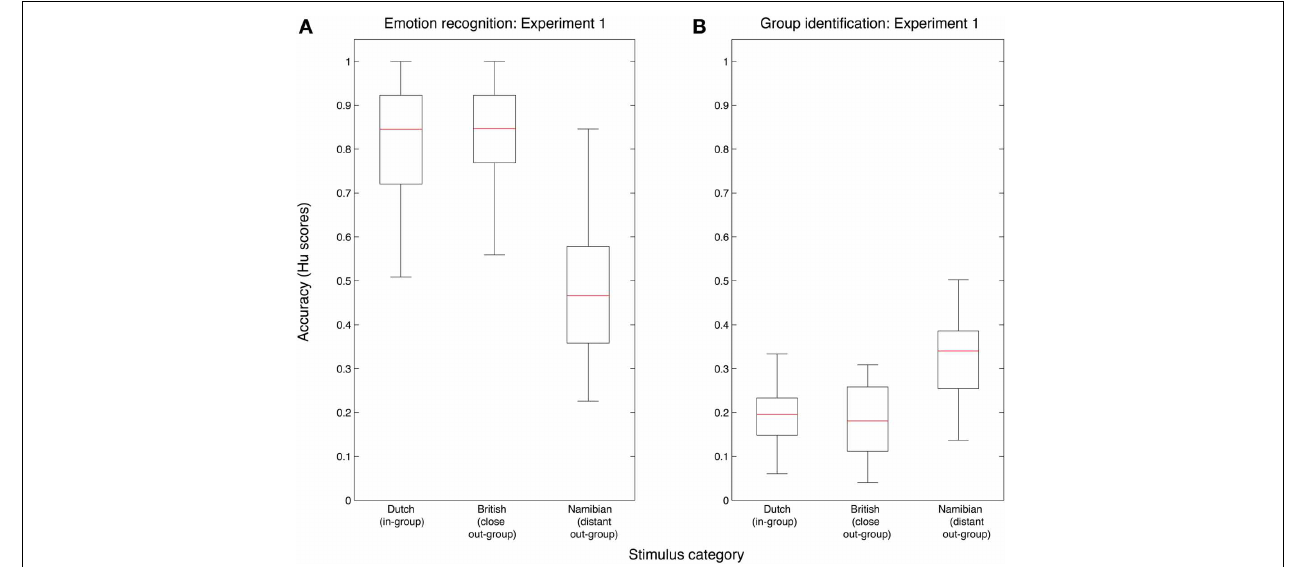
FIGURE 1 | Performance on the emotion recognition task (A) and the group identification task (B) in Experiment 1. Data are plotted by stimulus group using (raw) Hu scores, with Dutch, British, and Namibian stimuli shown